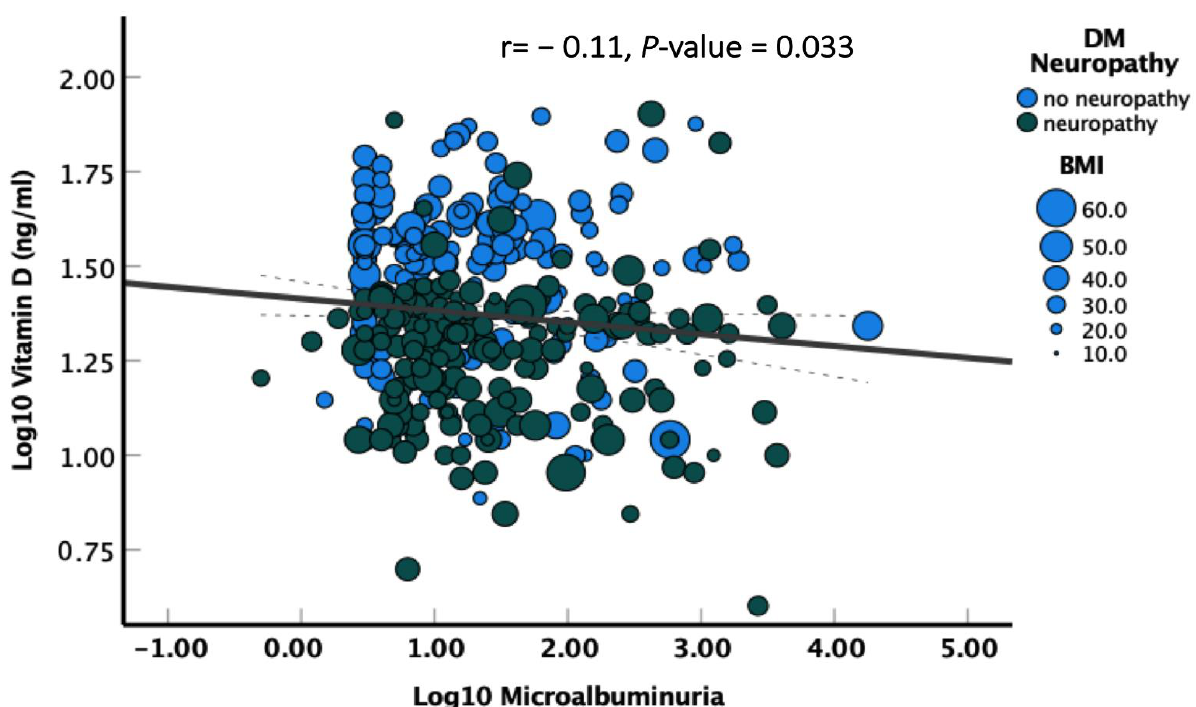
Figure 1. Correlation of log-transformed vitamin D and albuminuria values. Blue filled color circles represent DM with neuropathy, while green filled circles present DM without neuropathy. The size of the circles represent BMI values, with increasing values corresponding to larger circle size. Correlation was tested using Pearson ’s test with significance indicated by p -values less than 0.05.